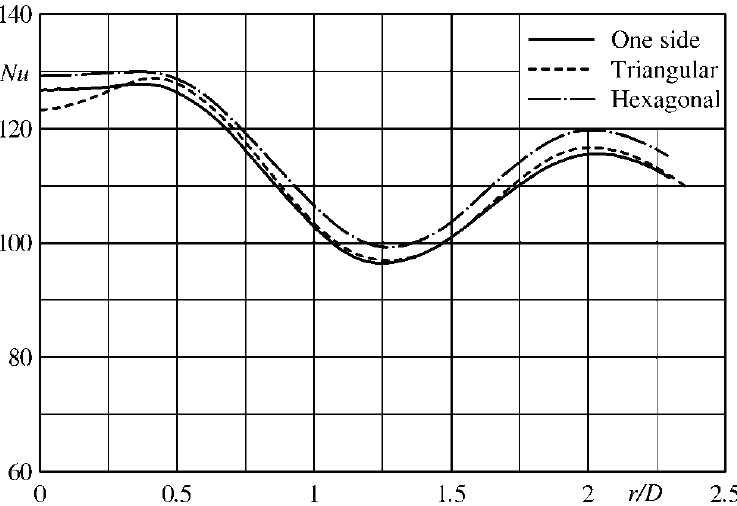
Figure 20. Azimuthally averaged profiles of the Nusselt number radial distributions of Figure 19 for the three heating configurations; Re = 30,000, z/D = 2. Data from Carlomagno et al .